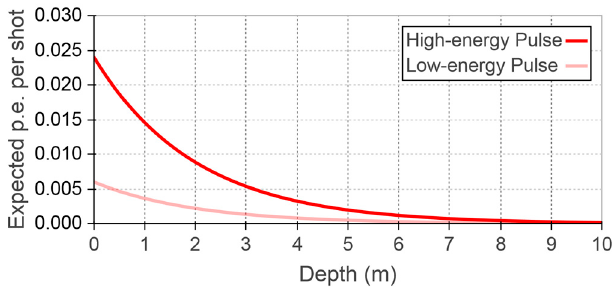
Figure 10. The predicted numbers of photoelectrons per pulse (or shot) vs. depth are shown for each energy level, for the Keweenaw Bay project site.